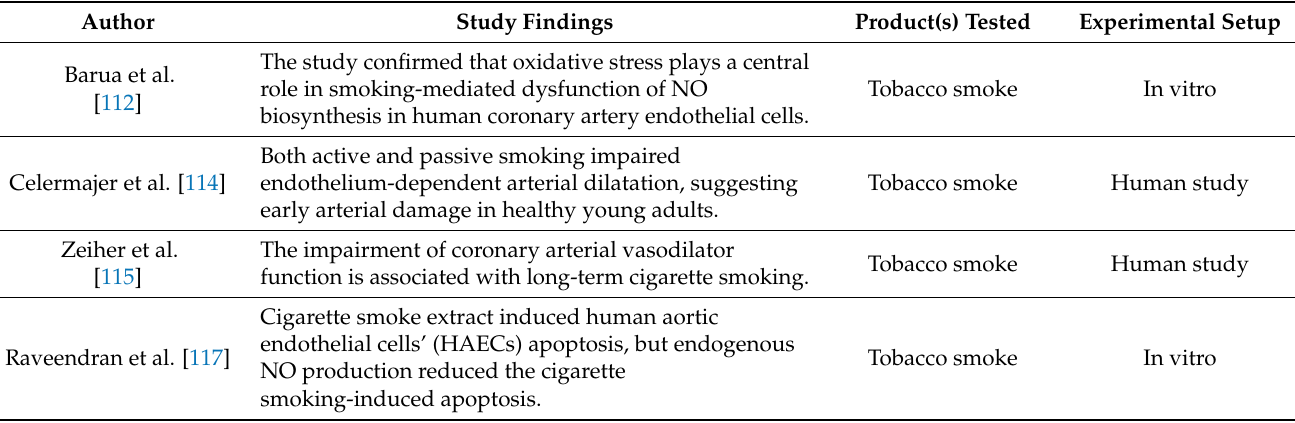
Table 2. Relevant research on oxidative stress related to tobacco smoke and NGP aerosols in cardio- vascular